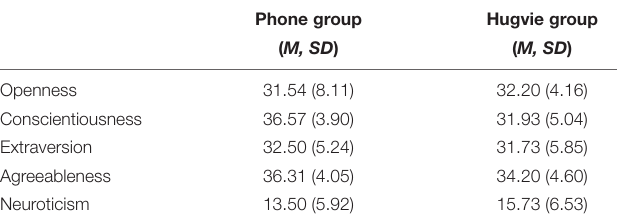
TABLE 1 | Description of personality traits for Phone and Hugvie